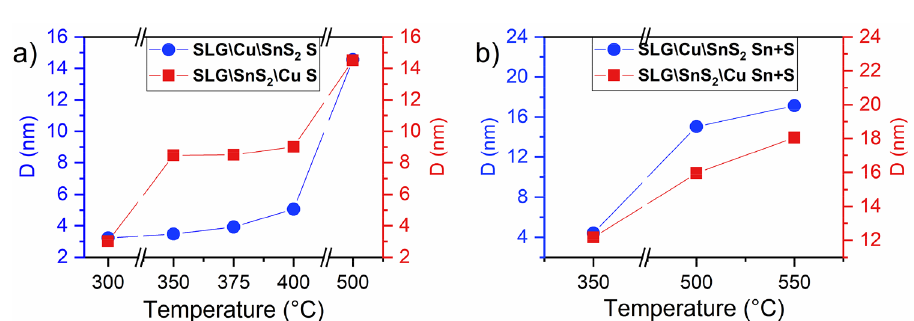
Figure 4. Average crystallite size in the SLG\Cu\SnS 2 (blue) and SLG\SnS 2 \Cu (red) stacks. Samples were annealed under ( a ) S and ( b ) Sn + S